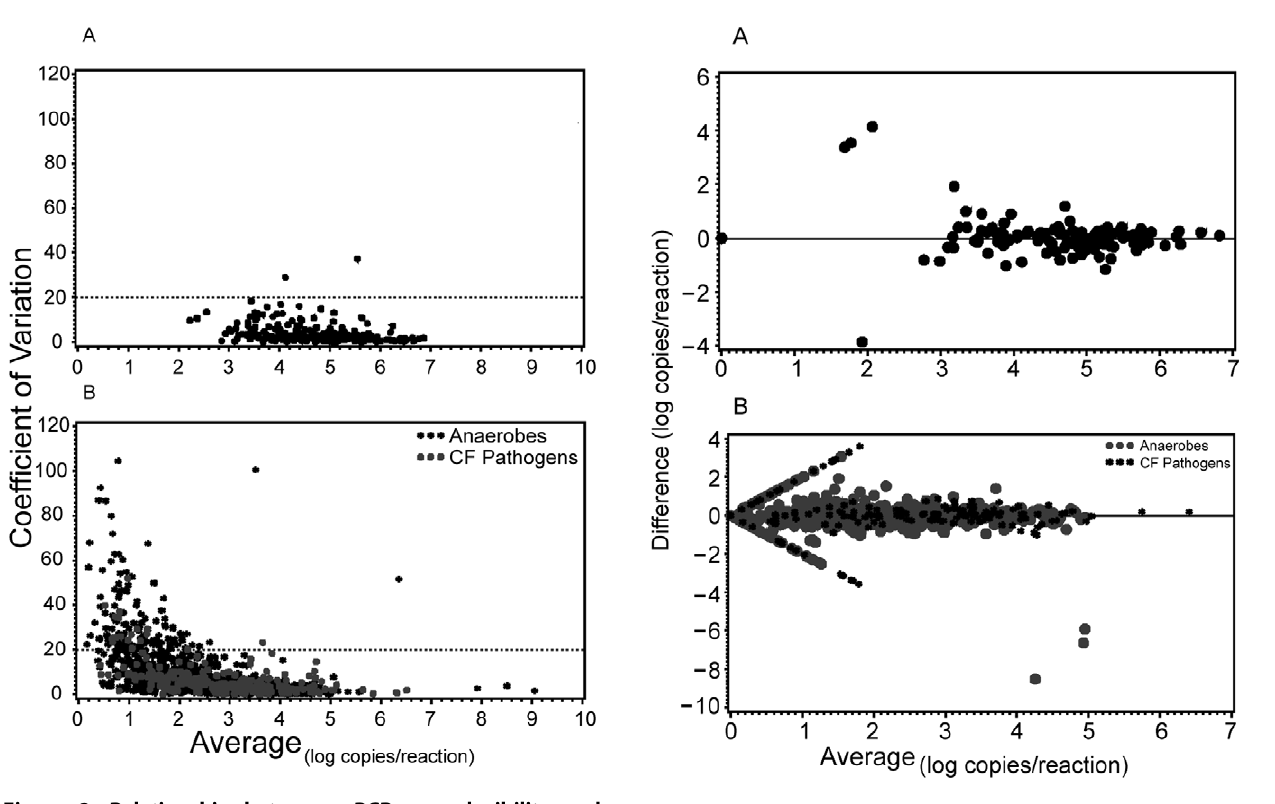
Figure 3. Comparison of qPCR assay results for split-sample measurements. Bland-Altman plots comparing split-sample measure- ments for (a) bacterial load assay (n=125 paired sample measure- ments), and (b) specific organism assays (n=1000 paired sample measurements). The straight lines indicate specimens with gene copies detected in one sample and not in the other matched